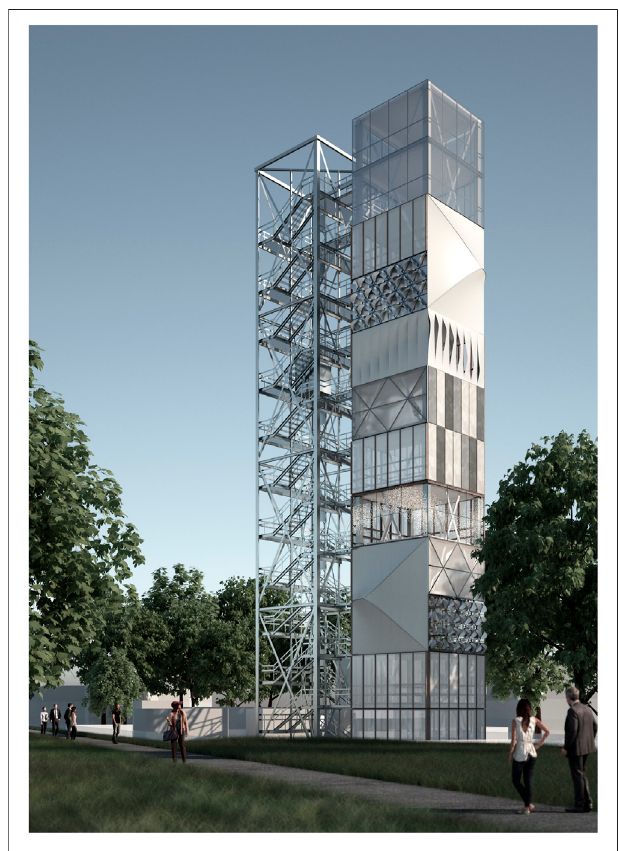
FIGURE 1 | Visualization of the experimental building (source: